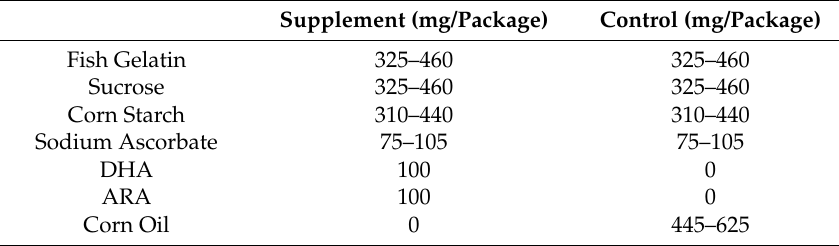
Table 1. Composition of